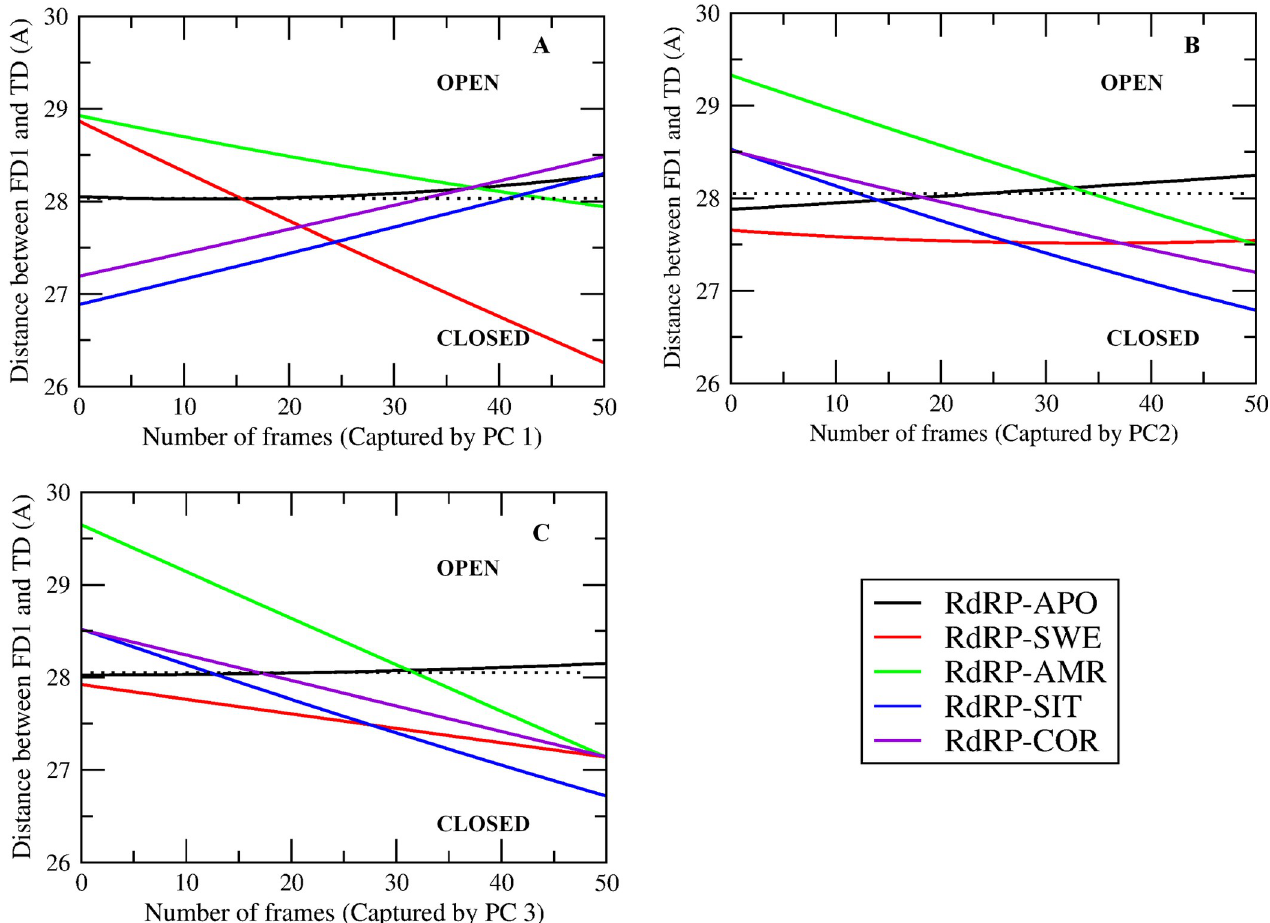
Fig 3. Open and closed conformations of RdRP. Distance between the finger subdomain 1 and thumb subdomain captured by principal component (A) 1, (B) 2 and (C) 3 in case of the five RdRP systems.